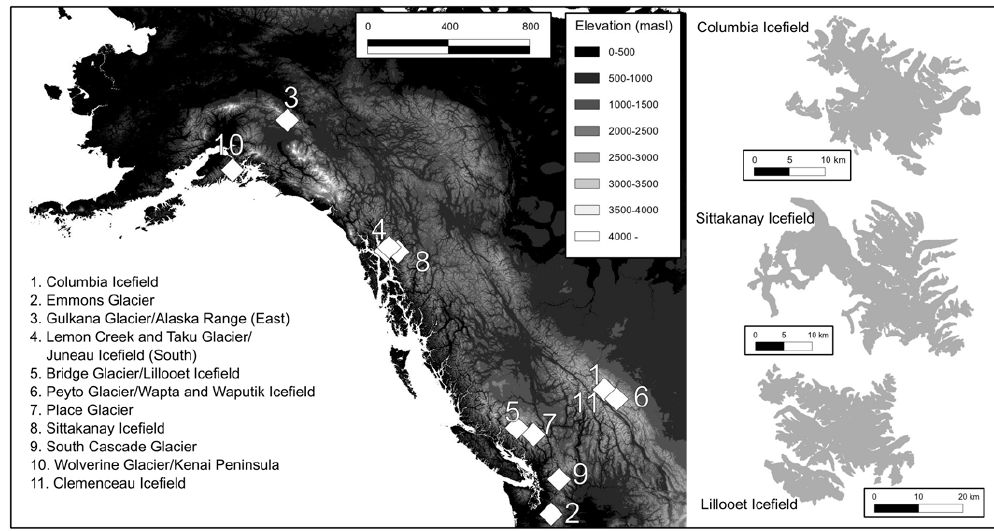
Fig. 1. Study area, with locations of index glaciers and geodetic mass balance sites. Columbia, Lillooet, Sittakanay icefields shown for